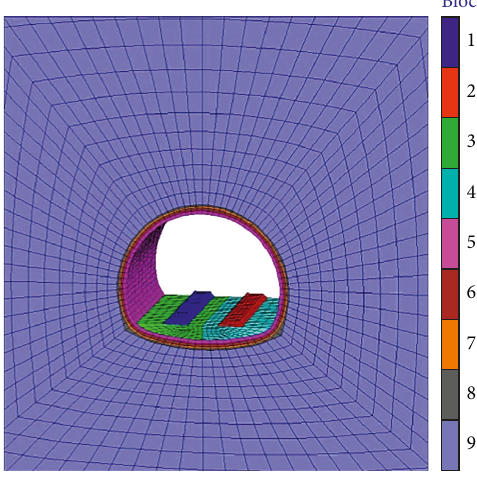
Figure 3: Numerical calculation